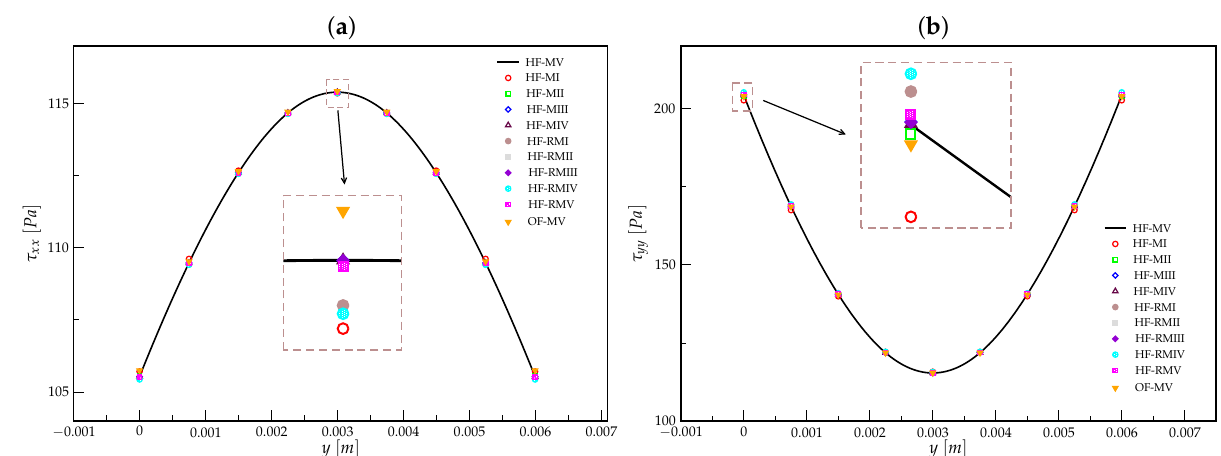
Figure 7. Comparison between the sumerical solutions of the tensor components obtained using HiGFlow (with different meshes) and OpenFOAM (mesh MV ). ( a ) τ xx and ( b ) τ yy tensor components.